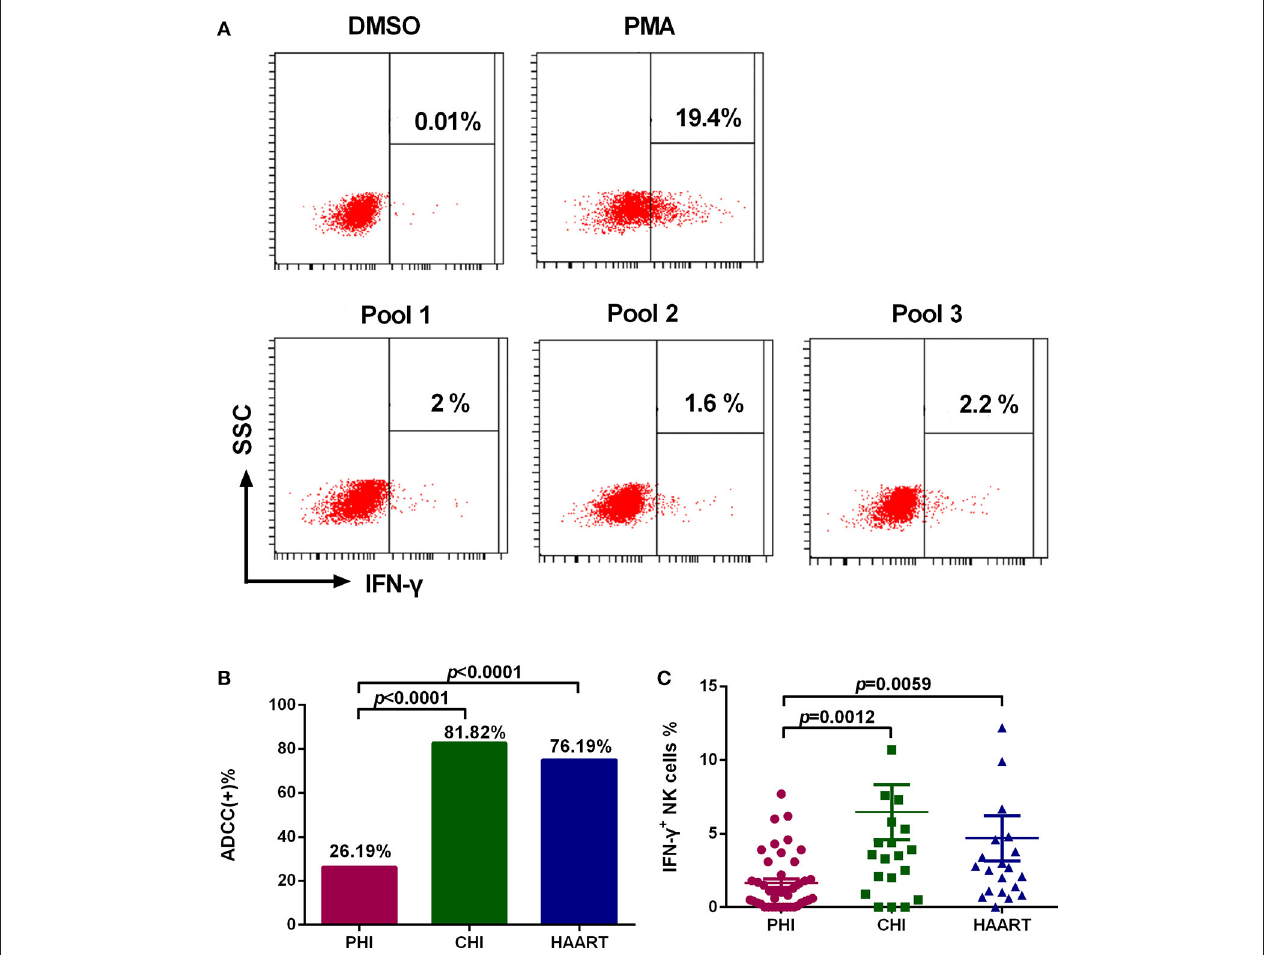
FIGURE 2 | Characteristics of the ADCC response in HIV-infected individuals. (A) Flow cytometry plots of IFN- γ production in samples from an individual with PHI at 52 days after infection, incubated with DMSO (negative control), PMA (positive control), and HIV peptide Pools 1, 2, or 3. (B) Rates of positive ADCC responses in the PHI ( n = 42), CHI ( n = 22), and HAART ( n = 21) groups. (C) Comparison of the percentages of IFN- γ + NK cells during ADCC responses of the PHI ( n = 42), CHI ( n = 22), and HAART ( n = 21)